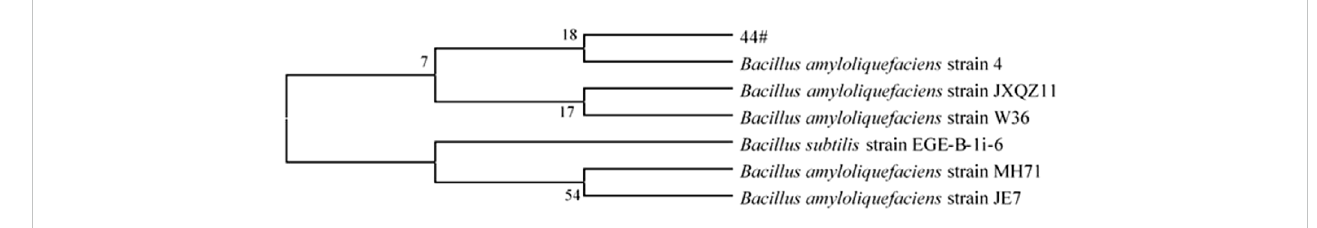
FIGURE 2 Phylogenetic tree of B. amyloliquefaciens 44#.